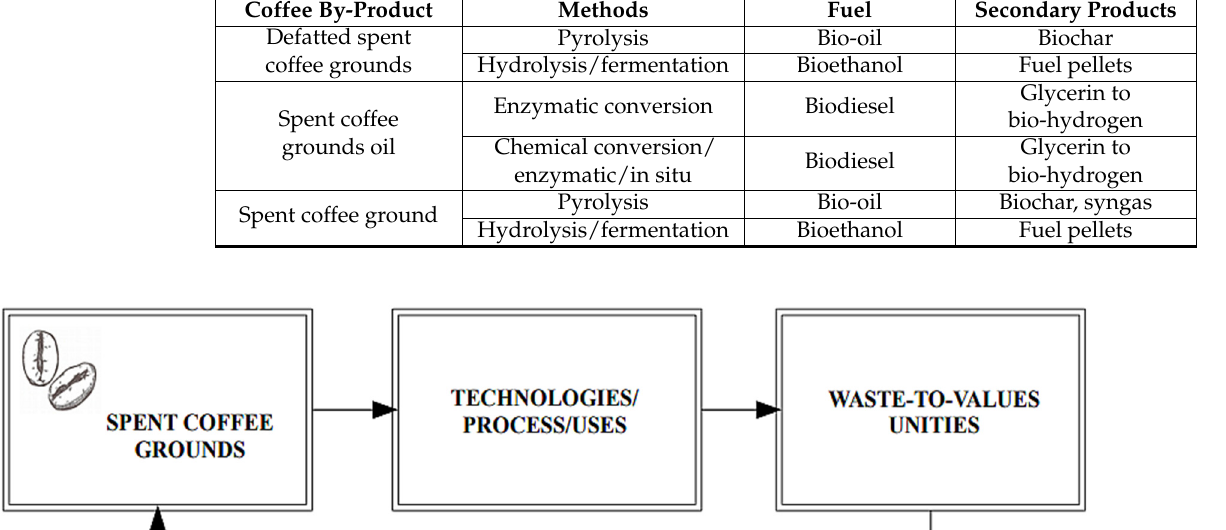
Table 3. Examples of the valorization of coffee processing by-products in energy production. Own compilation based on literature data [14].